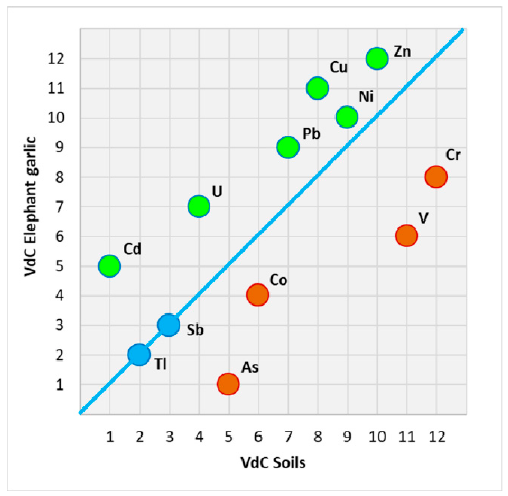
Figure 3. Scatterplot of PTE concentration ranks in elephant garlic vs. soil from the Valdichiana area. Elements in green are preferentially accumulated in elephant garlic; elements in red are found preferentially in the soil.